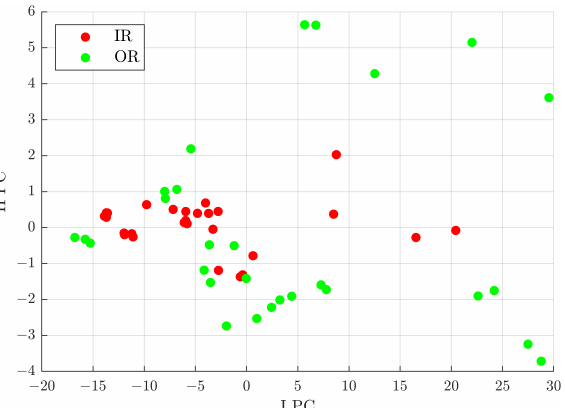
Figure 18. Distribution in the I PC–II PC plane of the analysed signals, from a rolling bearing with a defect on the inner raceway (IR) and on the outer one (OR), with respect to the characteristics selected by the Pareto method out of 11 after denoising with Group 49.